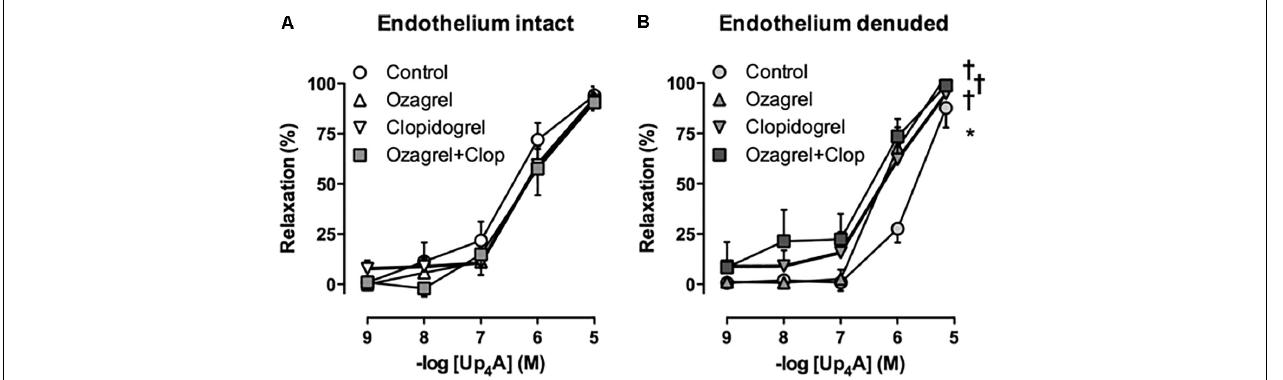
FIGURE 9 | Neither TxS inhibition with ozagrel, nor P2Y 12 receptor blockade with clopidogrel (Clop), nor the combination affected the response to Up 4 A in coronary small arteries from slaughterhouse swine with intact endothelium ( A , n = 5). Ozagrel and clopidogrel enhanced vasodilator response to Up 4 A in denuded coronary small arteries, while the effect of the combination of ozagrel and clopidogrel was similar to the effect of either inhibitor alone ( B , n = 5). Control data are the same as in Figure 2 ‘Slaughterhouse.’ ∗ P < 0.05 effect of denudation; † P < 0.05 effect of ozagrel and/or clopidogrel vs. corresponding